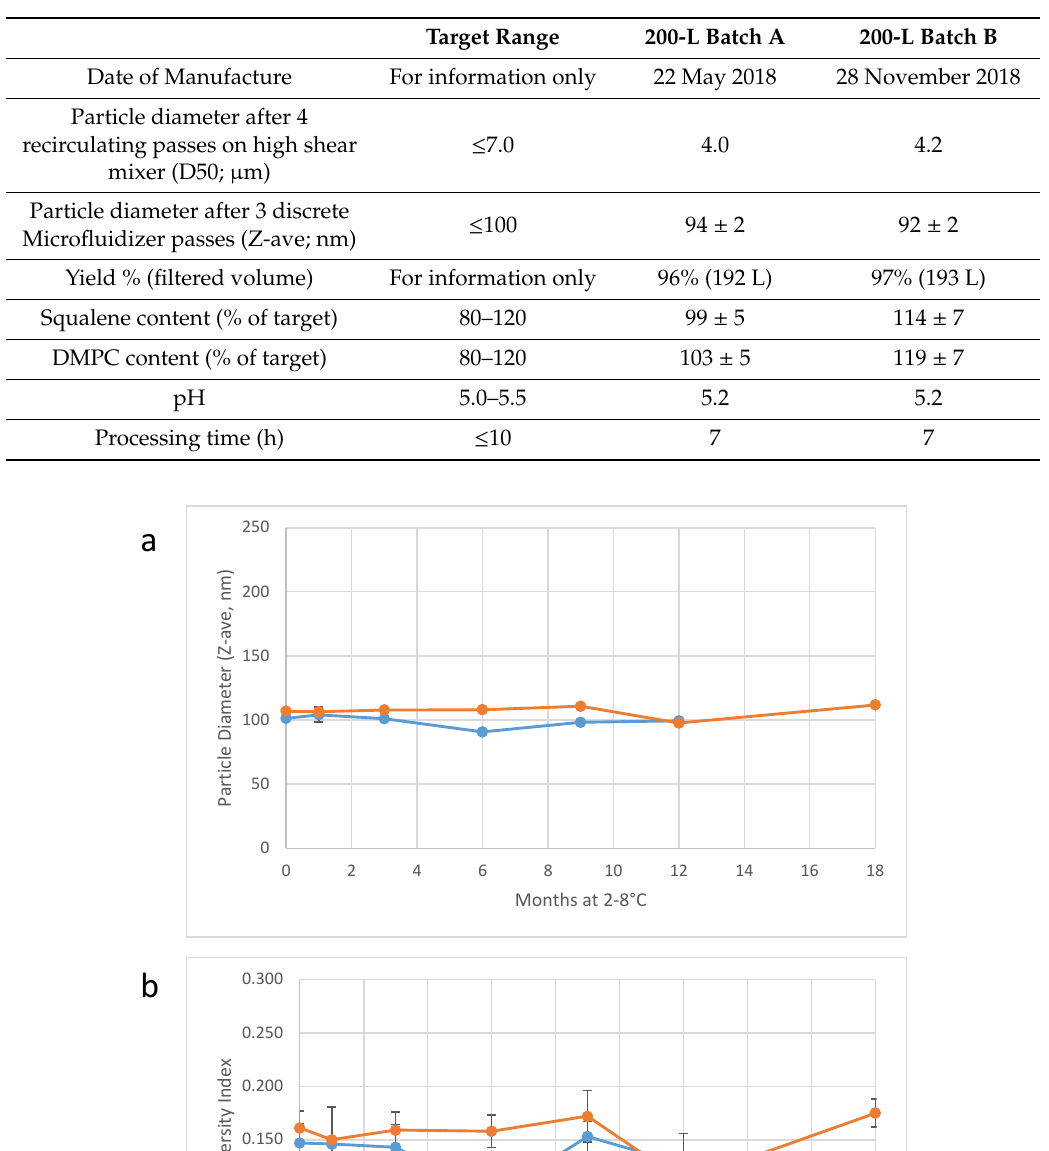
Table 7. Large-scale (200 L) 30% v / v SE batch characterization.